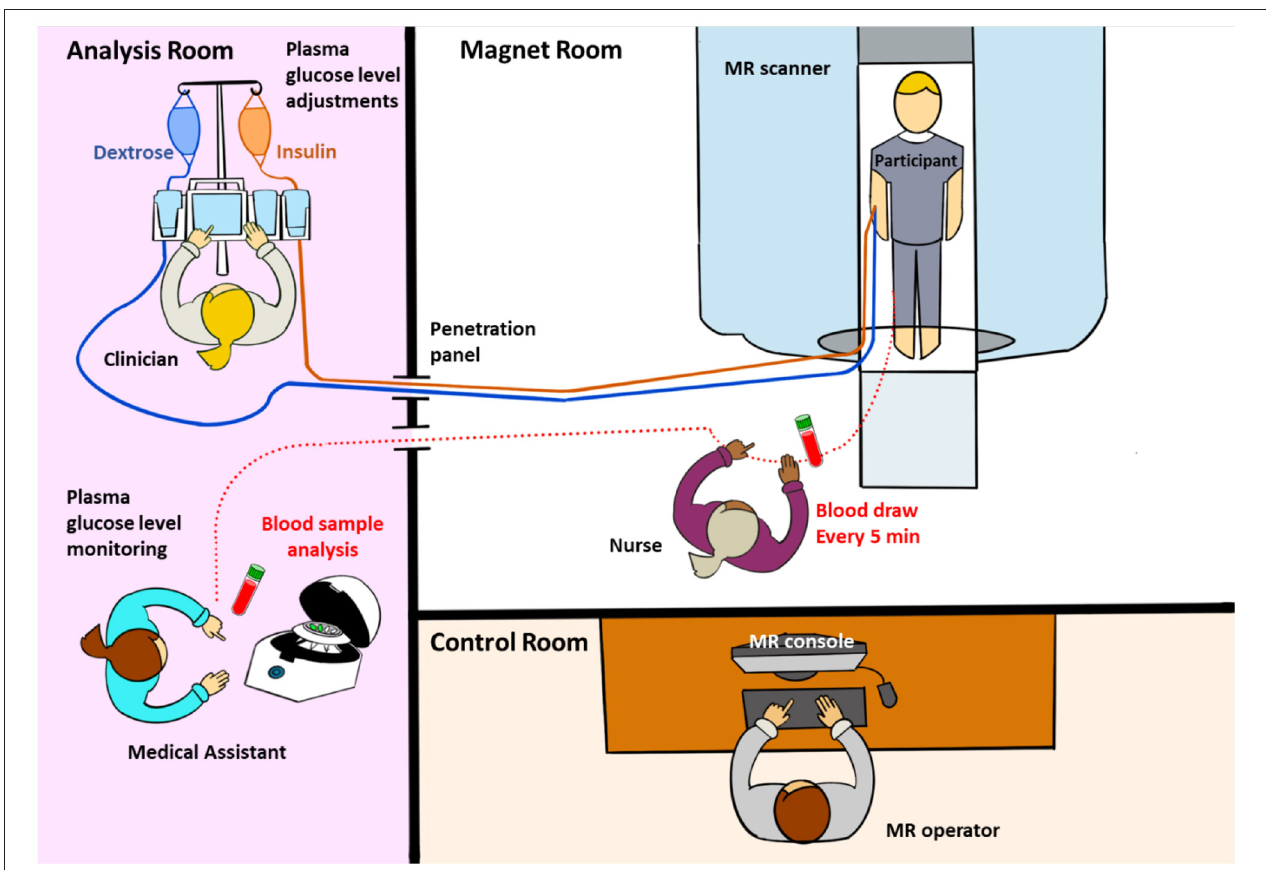
FIGURE 4 | MRI/magnetic resonance spectroscopy (MRS) data acquisition during glucose